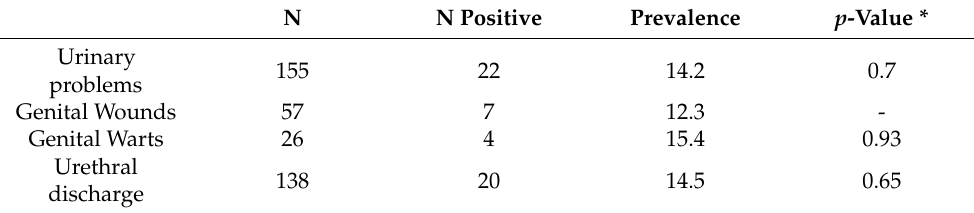
Table 3. Seroprevalences of HSV-2 (anti-HSV-2 IgM) in individuals exhibiting clinical symptoms in Indigenous community, Mato Grosso do Sul, Brazil. N N Positive Prevalence p -Value * Urinary 155 22 14.2 problems Genital